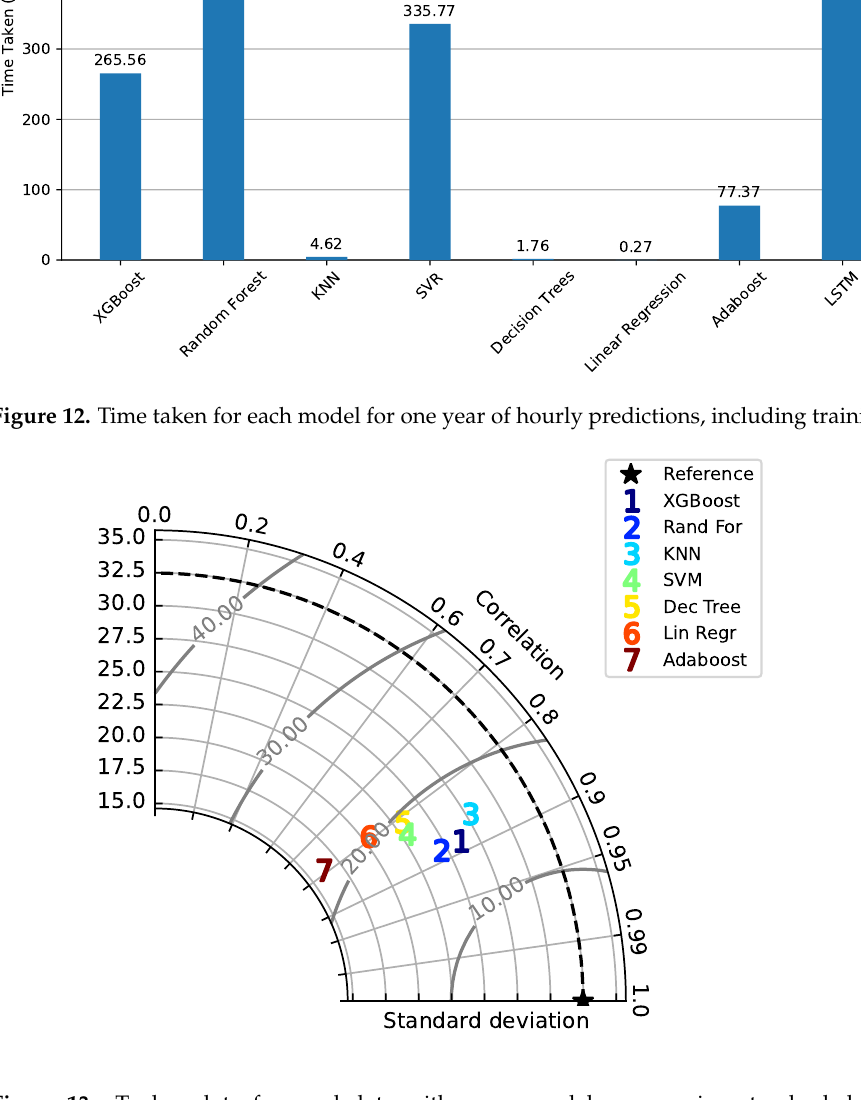
Figure 13. Taylor plot of annual data with seven models, comparing standard deviation (in micrograms/m 3 ozone) versus